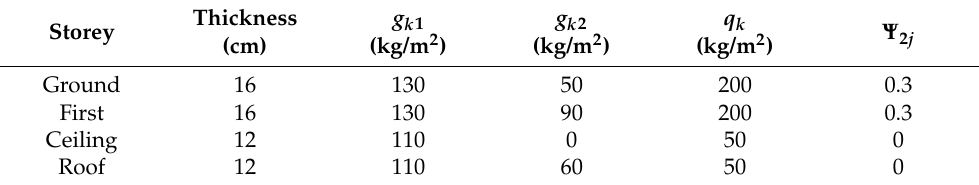
Table 2. Dead and live loads on diaphragms of the IACP